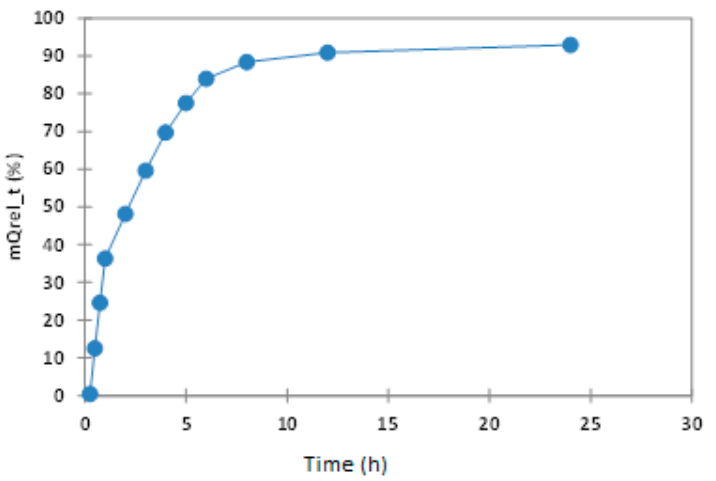
Figure 11. Interval plots of the percentage of QUE released (mQUErel (%)) from the microspheres for Time factor levels.